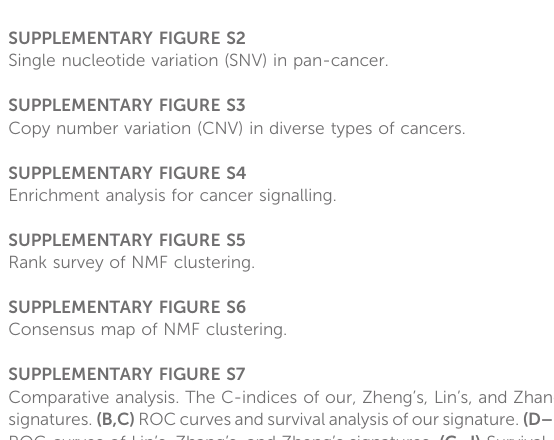
SUPPLEMENTARY FIGURE S1 Spearman correlations between CNRGs in both TCGA and CGGA cohorts. SUPPLEMENTARY FIGURE S2 Single nucleotide variation (SNV) in pan-cancer. SUPPLEMENTARY FIGURE S3 Copy number variation (CNV) in diverse types of cancers. SUPPLEMENTARY FIGURE S4 Enrichment analysis for cancer signalling. SUPPLEMENTARY FIGURE S5 Rank survey of NMF clustering. SUPPLEMENTARY FIGURE S6 Consensus map of NMF clustering. SUPPLEMENTARY FIGURE S7 Comparative analysis. The C-indices of our, Zheng ’ s, Lin ’ s, and Zhang ’ s signatures. (B,C) ROCcurvesandsurvivalanalysisofoursignature. (D – F) ROC curves of Lin ’ s, Zhang ’ s, and Zheng ’ s signatures. (G – I) Survival analysis of Lin ’ s, Zhang ’ s, and Zheng ’ s